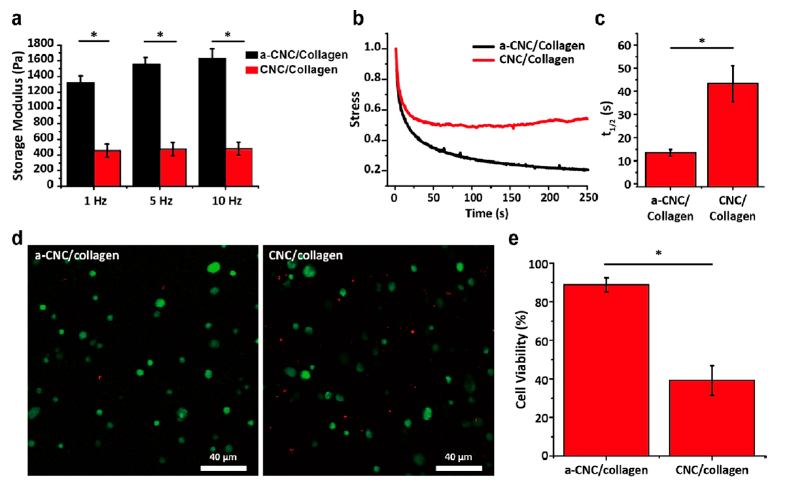
Figure 11. ( a ) Storage modulus of a-CNC/collagen and CNC/collagen hydrogels at frequencies of 1, 5 and 10 Hz; ( b ) representative relaxation stress curves of the hydrogels at a strain of 1%, which was normalized to the initial stress; ( c ) stress-relaxation time of the hydrogels when the stress dropped to half of its initial values; ( d ) representative live/dead staining images of the MSCs encapsulated in the hydrogels post-injection (scale bar 100 μ m); ( e ) quantification of cell viability from the live/dead staining (reprinted from Zhang et al., 2020 [21], with the permission of American Chemical Society, published under license. Copyright © 2022 American Chemical Society). “*” highlights the